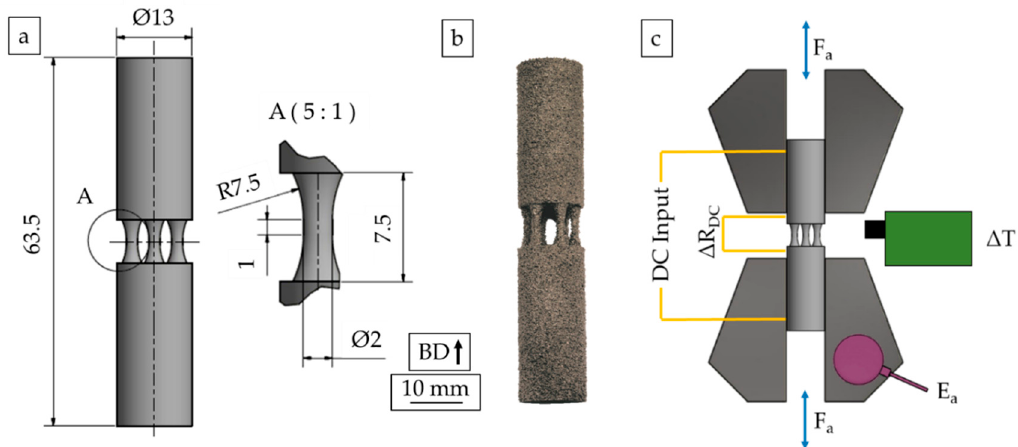
Figure 1. ( a ) CAD geometry, ( b ) final specimen geometry in as-built condition, and ( c ) schematic illustration of the experimental setup used for load increase test (LIT).